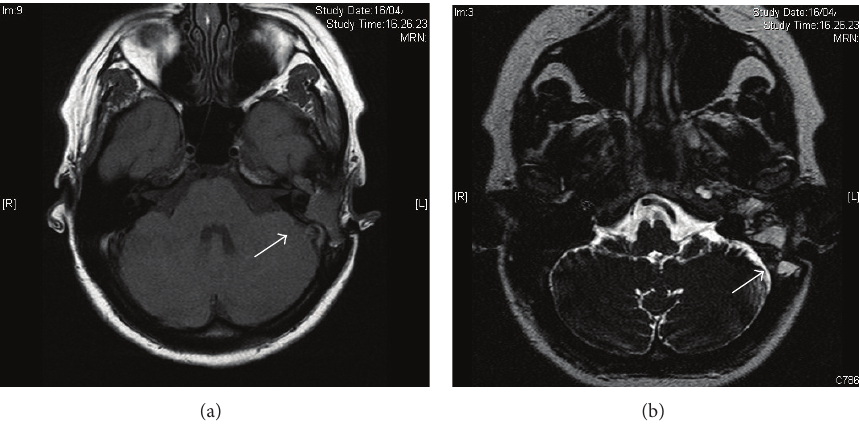
Figure 3: Axial T1-weighted cerebral MRI confirmed the presence of a lesion of increased signal, similar to brain tissue (a); the tumor (22 × 15 × 11mm) enhanced with gadolinium in the medial portion of middle ear and in the tubaric region (b).